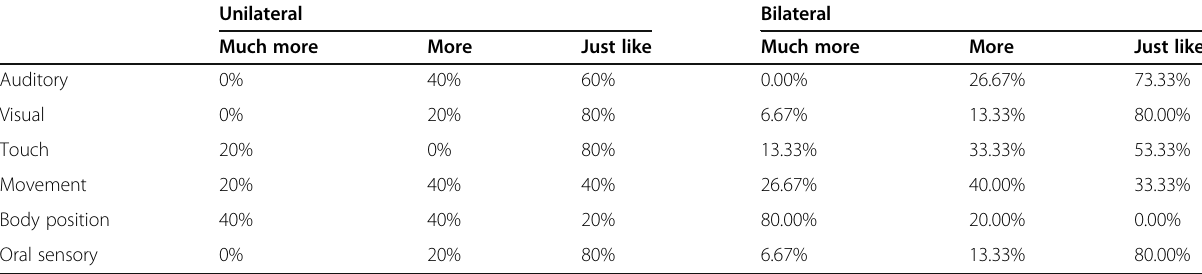
Table 4 Distribution of children of each group (unilateral and bilateral SCP) in the sensory systems